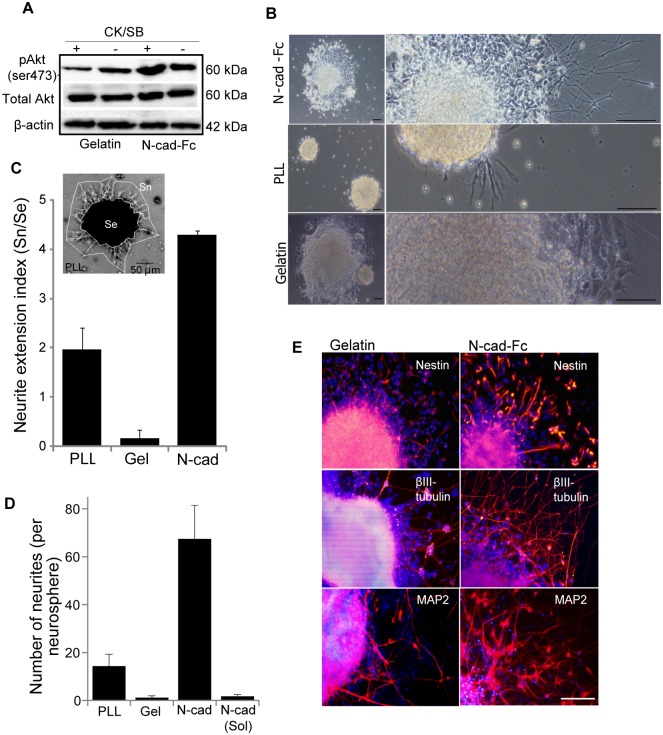
Enhancement of neurite outgrowth by substrate bound N-cadherin.Neurospheres generated in suspension for 5 days with and without CKI-7/SB-431542 were cultured on substrates pre-coated with N-cad-Fc, PLL, or gelatin for 48 hrs in the absence of growth factors. (A) N-cadherin substrate leads to upregulation of Ser473P (active) Akt in NPCs, as analyzed by western blot. (B) Cellular phenotype on different extracellular matrices was assessed by bright-field microscopy. (C) The degree of neurite outgrowth on the N-cad-Fc, gelatin, and PLL was quantified by neurite extension index, defined as the ratio of neurite outgrowth surface (Sn) and explant surface (Se). (D) The number of neurites per neurosphere was analyzed from bright-field images. Soluble N-cad-Fc was added in the growth medium of explants grown on gelatin substrate. (E) Immunofluorescence microscopy analysis of Nestin, βIII-tubulin, and MAP2 expression. DAPI shows total nuclei in the field of view. Data are mean ± SD, n = 3. Scale bar is equivalent to 50 μm unless otherwise mentioned. Abbreviation: PLL- poly-L-lysine; sol, soluble; Ncad, N-cad-Fc; Gel, gelatin.